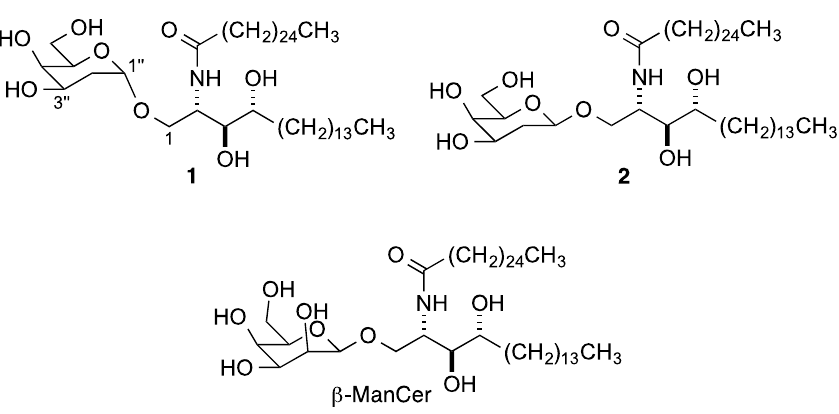
Figure 1. 2 ꞌꞌ -Deoxy galactosyl ceramides 1 and 2 and β